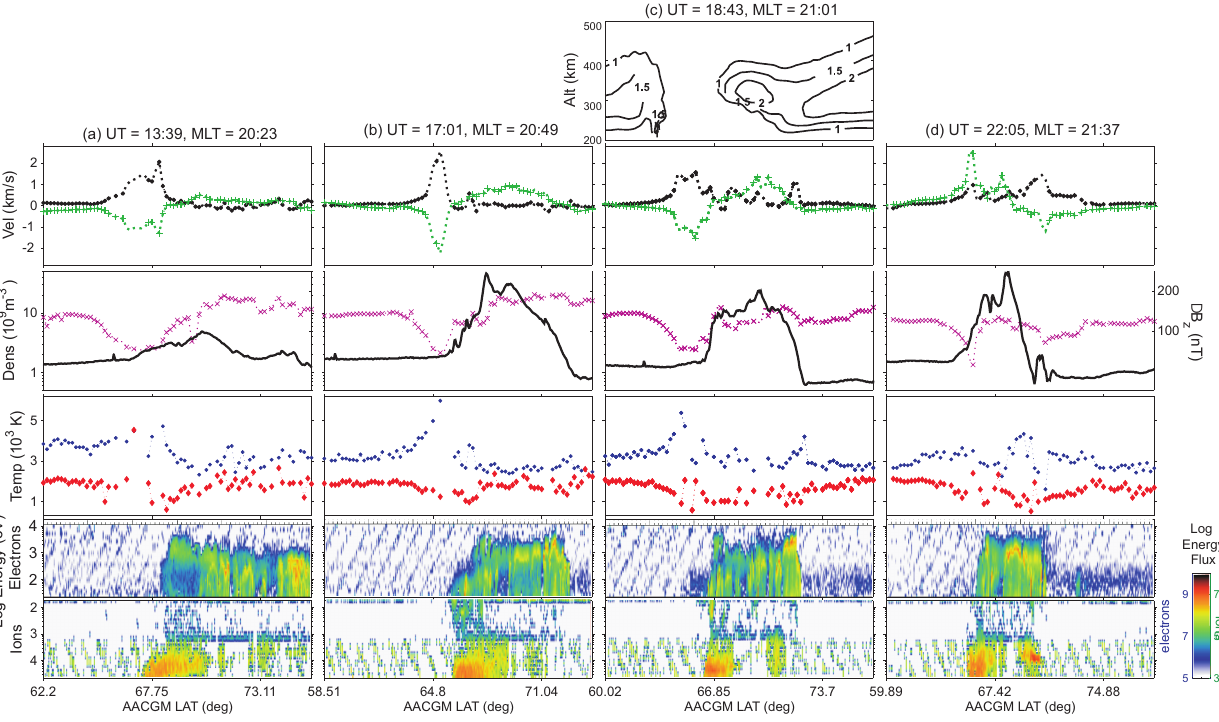
Fig. 2. The case of 12 October 2003. See caption of Fig. 1 for details. Note that, in this figure, the reconstructed F-region density is on top of the third vertical